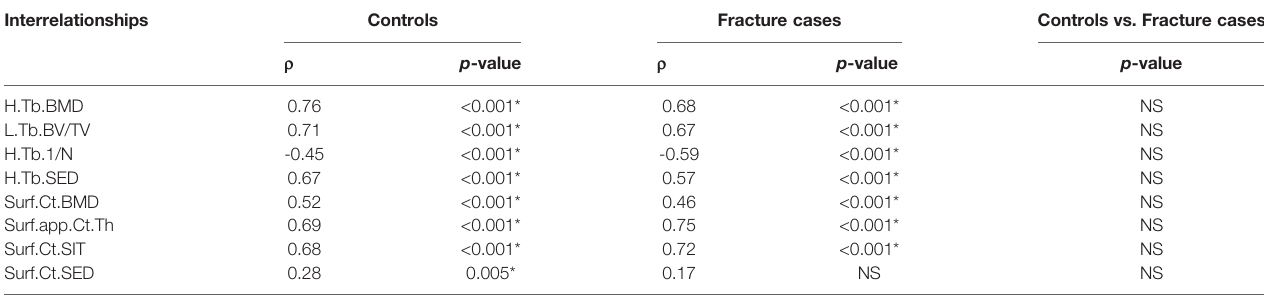
TABLE 6 | Global compartmental Spearman ’ s rank partial correlations of m FEA.FL with homogenized and local trabecular voxel-based parameters, and cortical surface- based parameters with no spatial